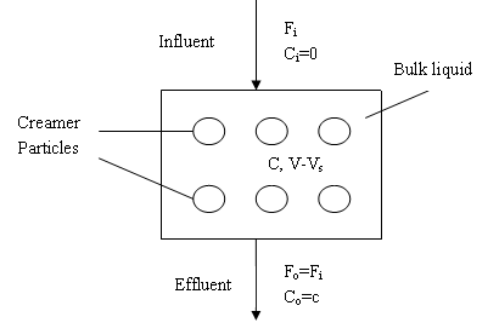
Fig. 2. Dynamic mass balance of creamer in the creamer layer at time t.